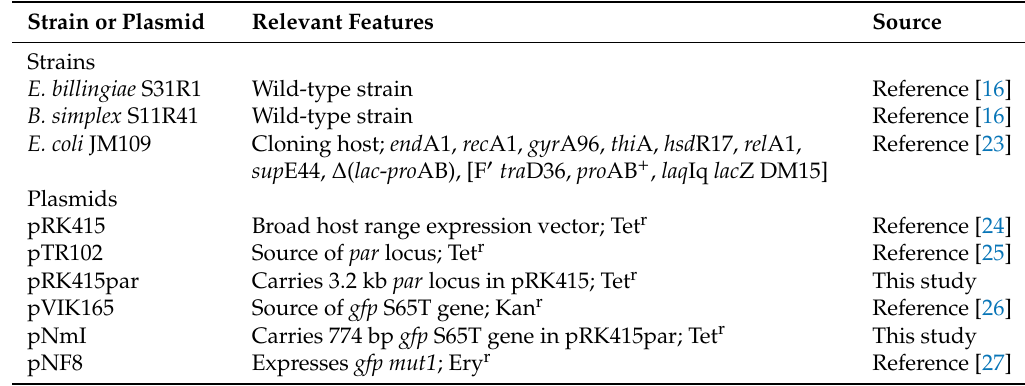
Table 1. Bacterial strains and plasmids used in this